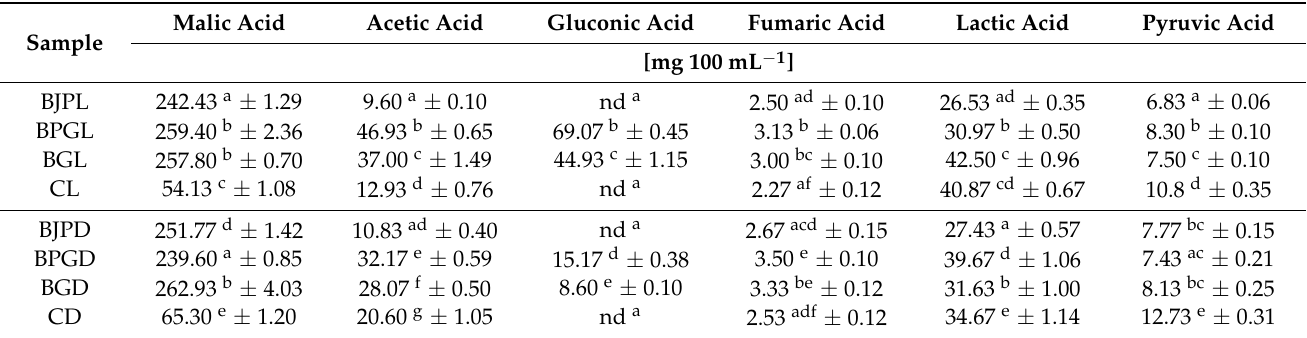
Table 4. Average results of physicochemical analyses (organic acids) in study beer beverages after the re-fermentation process.